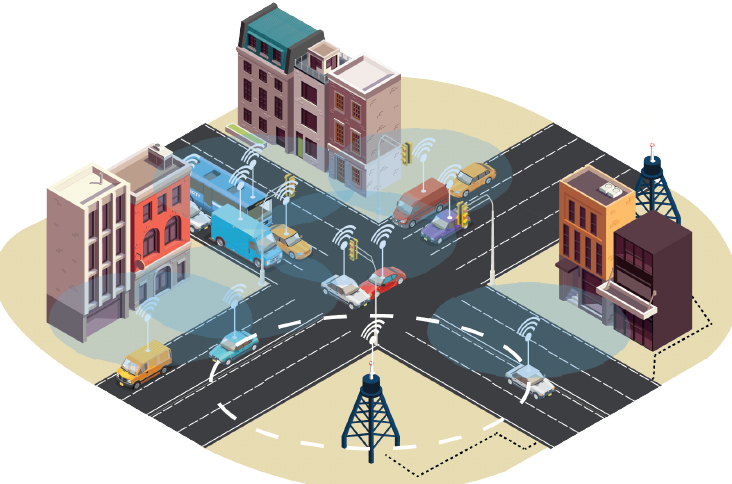
Figure 1. Vehicles in a VANET communicating when an accident occurs at the traffic light